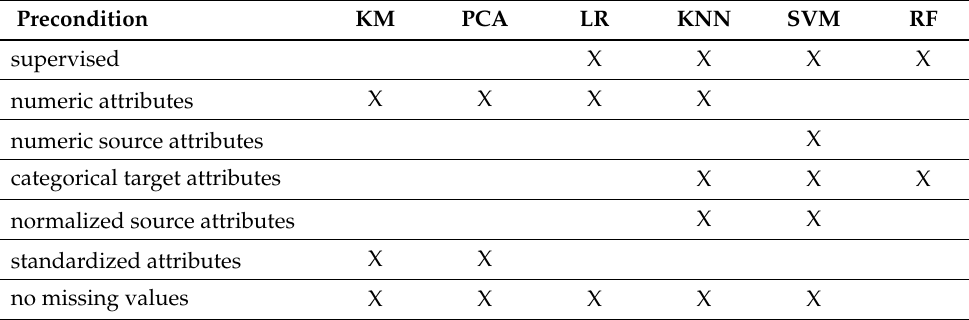
Table 1. Comparison of analysis methods and